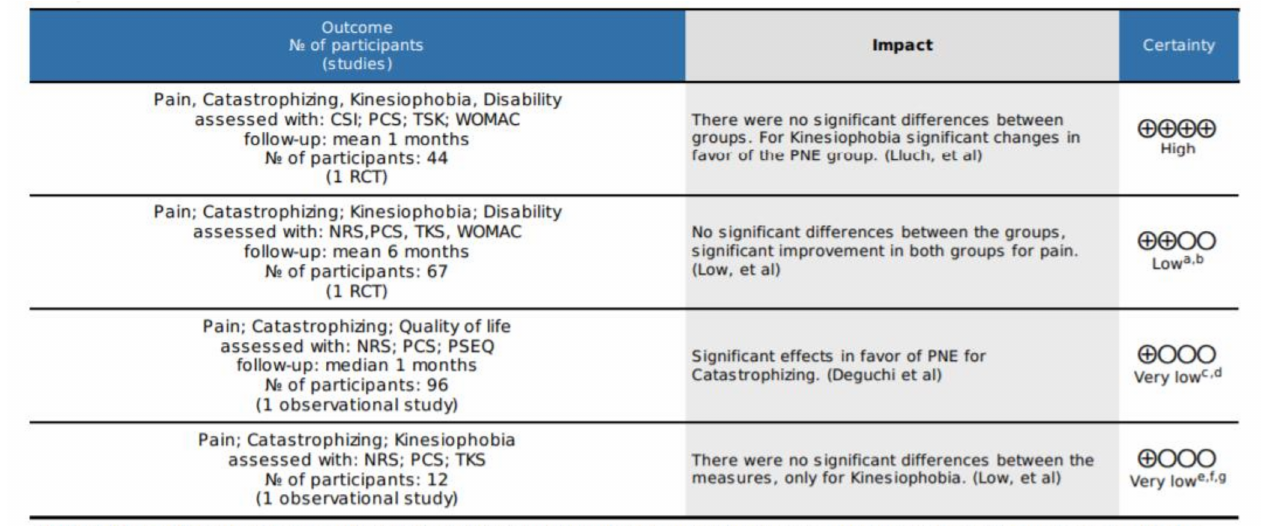
Figure 4. Certainty analysis with GRADE. Conventions: a One of the studies had no concealment or randomization and blinding of assessment. b Media and DS cannot be accessed, which makes it impossible to generate the meta-analysis. c There is no blinding of the evaluations, the collection of the patients is not clear. d The data differ from those reported with this scale in other studies. e there is no blinding of the evaluations, no second group was generated. f The measurements are generated in ranges. g The intervals are wide. Source: Own source with GRADEpro